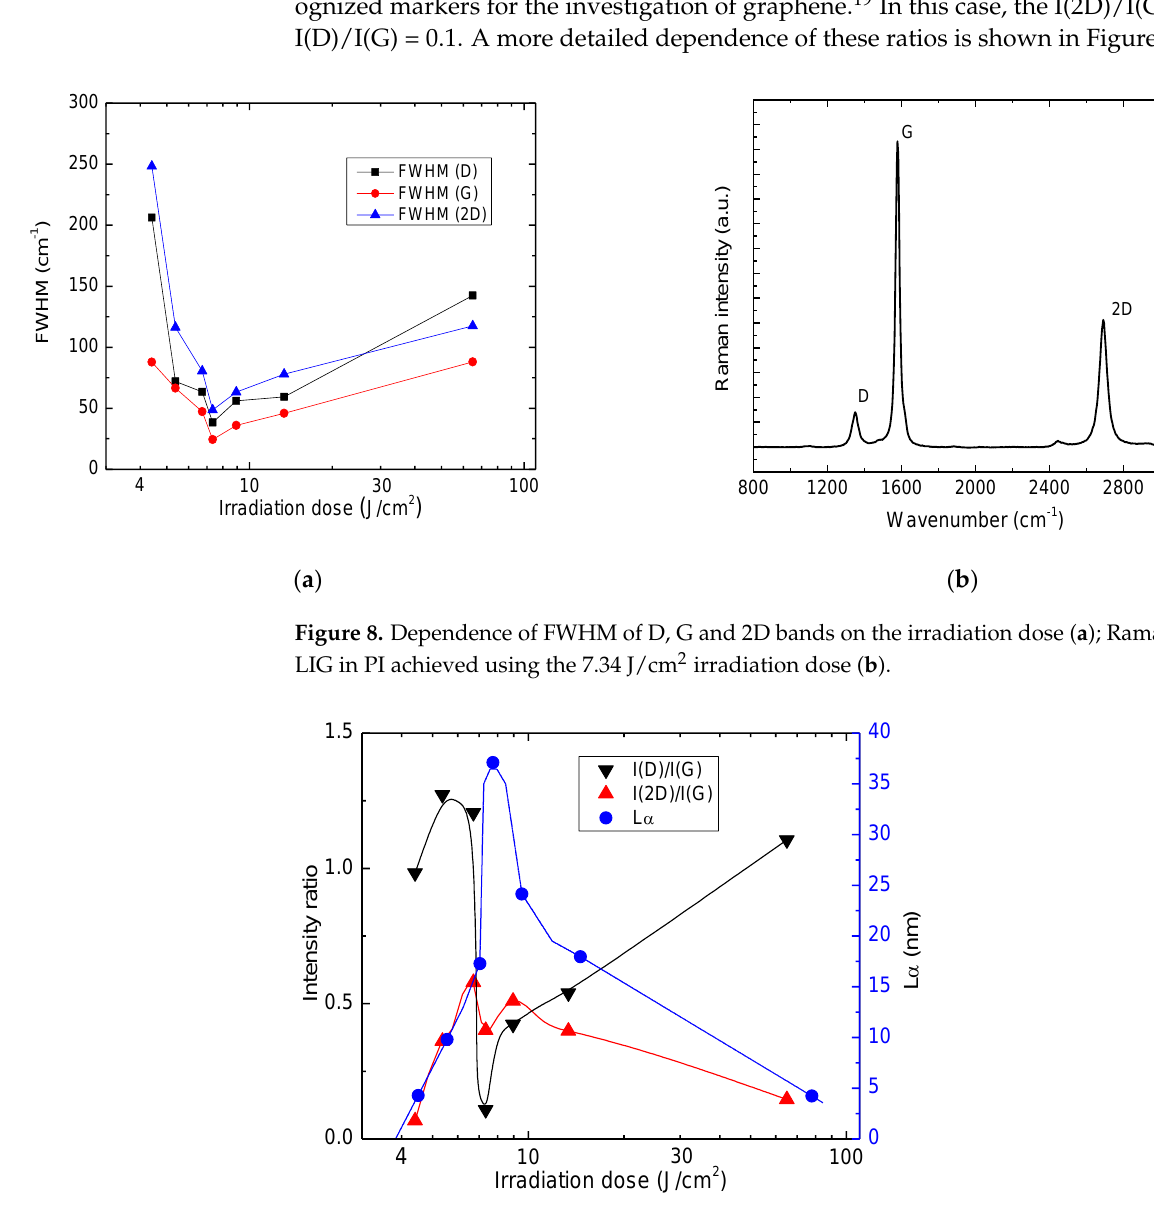
Figure 9. Dependence of I(D)/I(G) and I(2D)/I(G) intensity ratios and crystallite size L α on laser irradiation dose at 1064 nm.